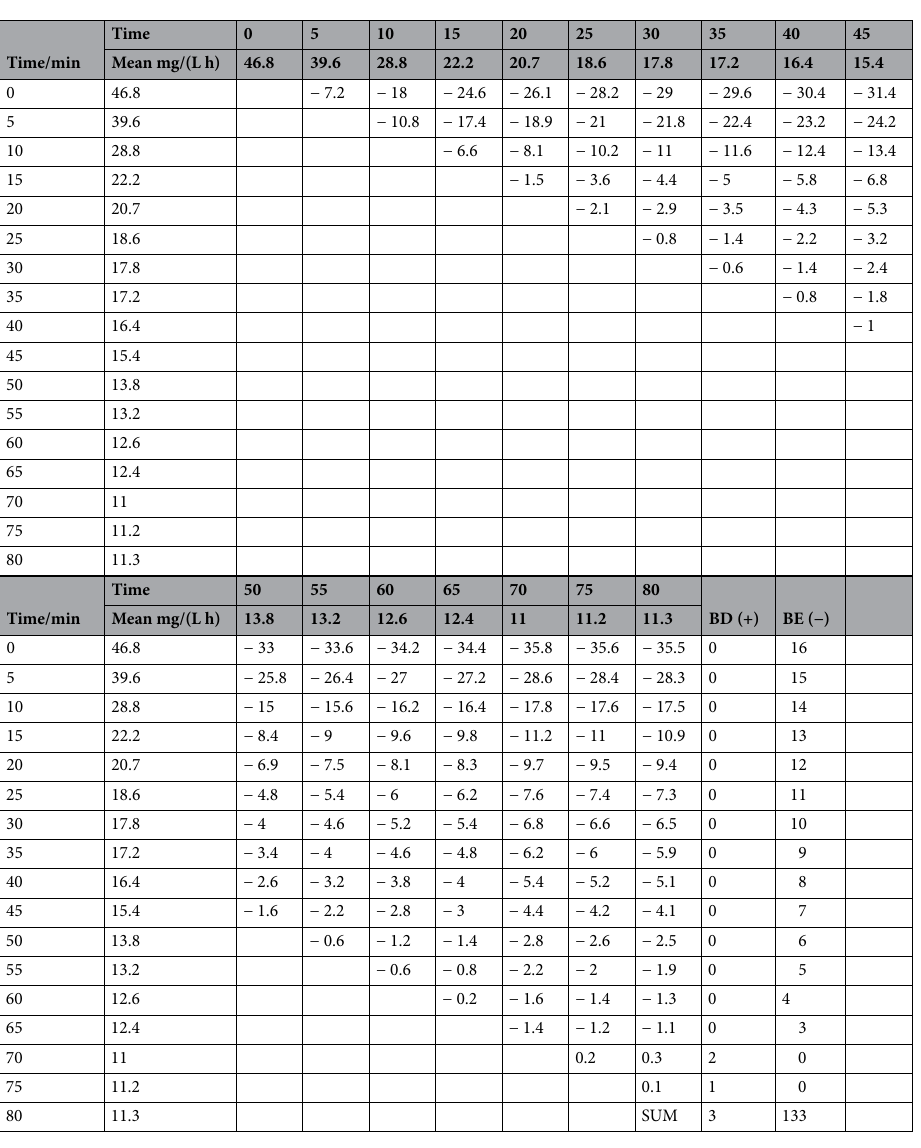
Table 2. Analysis of trend testing in